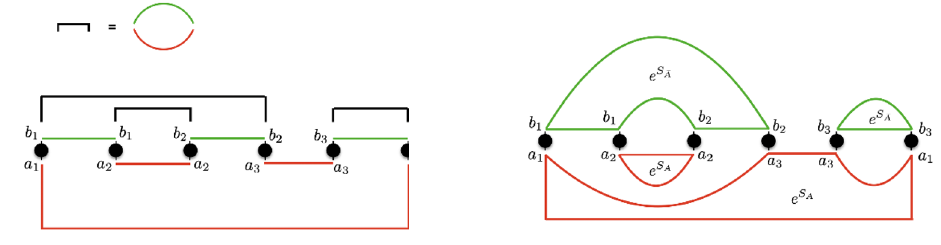
Figure 9 . An example of contractions (left) producing loop diagrams (right) for the case of n =